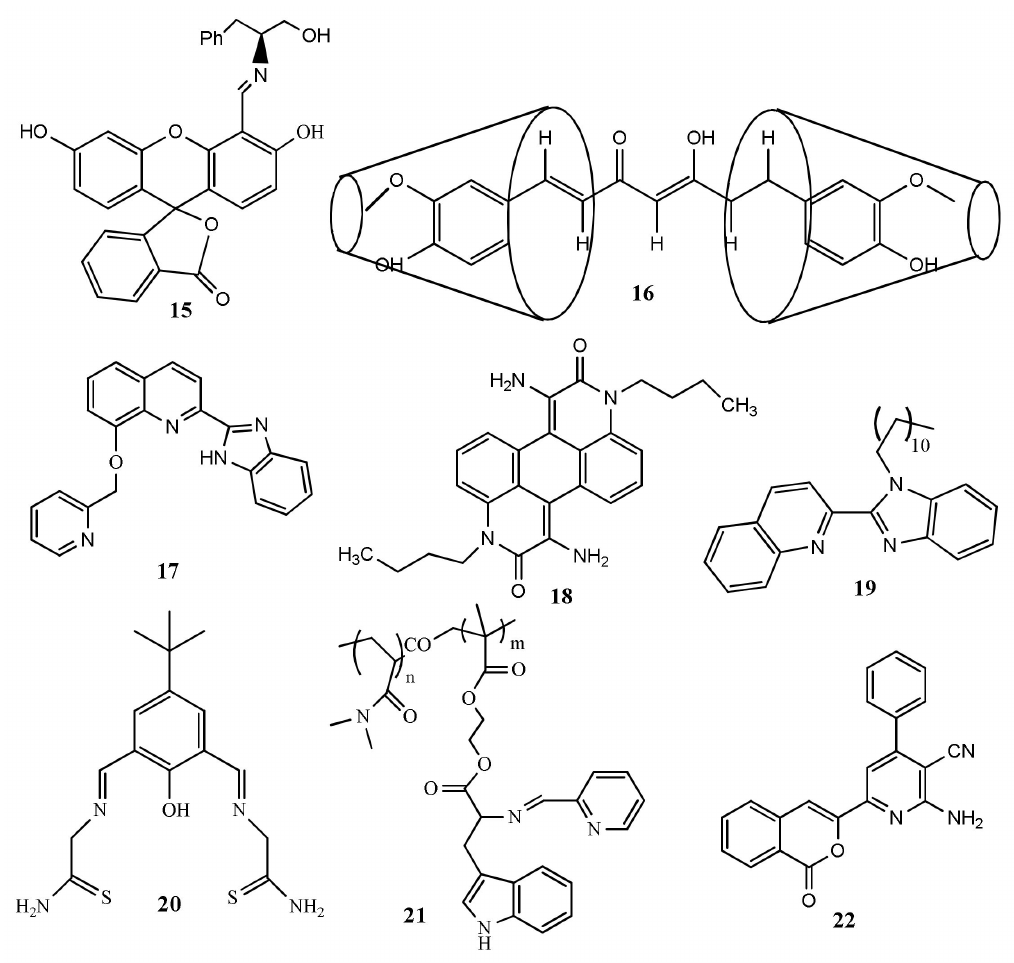
Figure 8. Molecular structures of the sensors 15 to 22 . The multi-analytes selective bis-thiosemicarbazone based receptor 20 (Figure 8) was developed for the detection of Hg 2+ , Zn 2+ and Cd 2+ in H 2 O:DMSO (95:5 v / v ) [51]. Sensor 20 showed an intense emission at 540 nm, while addition of Hg 2+ , the fluorescence was quenched and red-shifted to 578 nm with the color changed from yellow to reddish-brown ( λ ex = 360 nm). Color and fluorescence changes were attributed by intra-ligand fluorescence and influence of coordination of Hg 2+ to the receptor. The LOD for Hg 2+ was estimated as 0.51 µ M. With Zn 2+ and Cd 2+ , the fluorescence of 20 was blue-shifted and enhanced respectively at 488 and 470 nm. The tryptophan-based polymer 21 (Figure 8) was reported for the detection of Hg 2+ and Cu 2+ [52]. Sensor 21 showed dual emissions at 364 nm and 464 nm with the yellow colored fluorescence in aqueous medium at physiological pH. Upon complexation with Hg 2+ /Cu 2+ , sensor 21 showed significant quenching at 464 nm without any change at 364 nm. The quenching was attributed by PET process from the tryptophan donor to the pyridine acceptor unit. With 21 , the concentration of Hg 2+ and Cu 2+ can be detected down to 7.41 nM and 4.94 nM, respective, and applied for the bioimaging of intracellular Hg 2+ /Cu 2+ in live CP3 cells. The isocoumarin based sensor 22 (Figure 8)